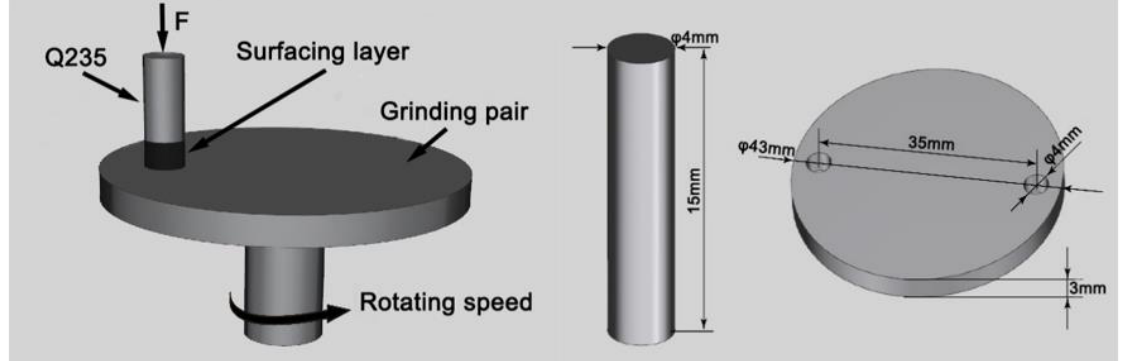
Table 3. Chemical composition of GCr15 (wt.%).